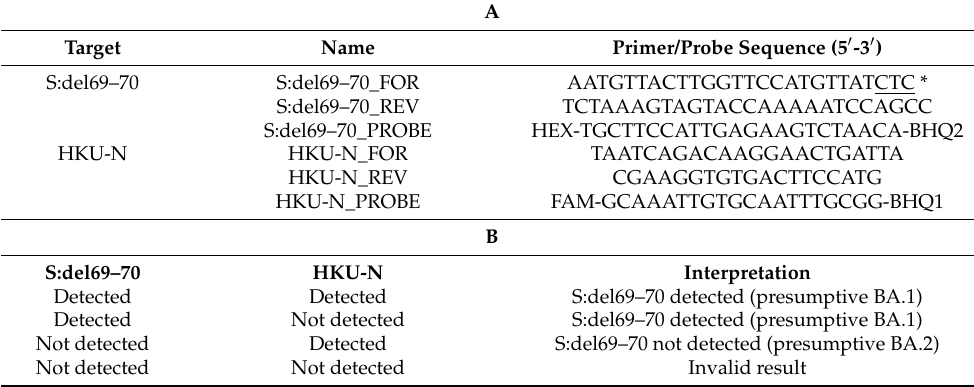
Table 2. A. Primers and probes for the detection of the S:del69–70 in variants of concern for SARS- CoV-2. B. Assay